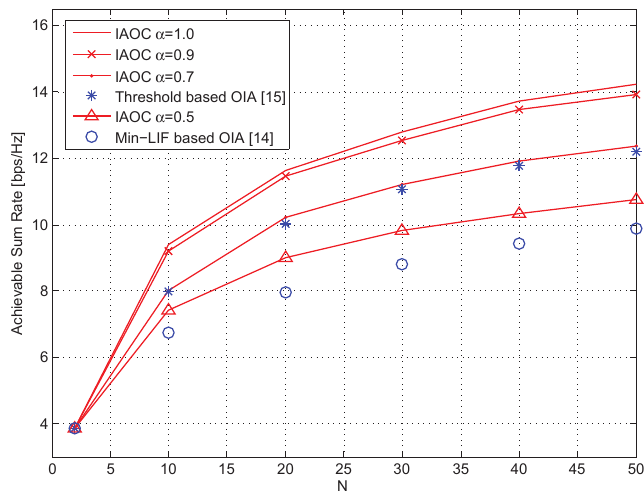
Figure 3. The achievable sum rate versus N . K = 3, N r = 3, N t = 2, S = 2.